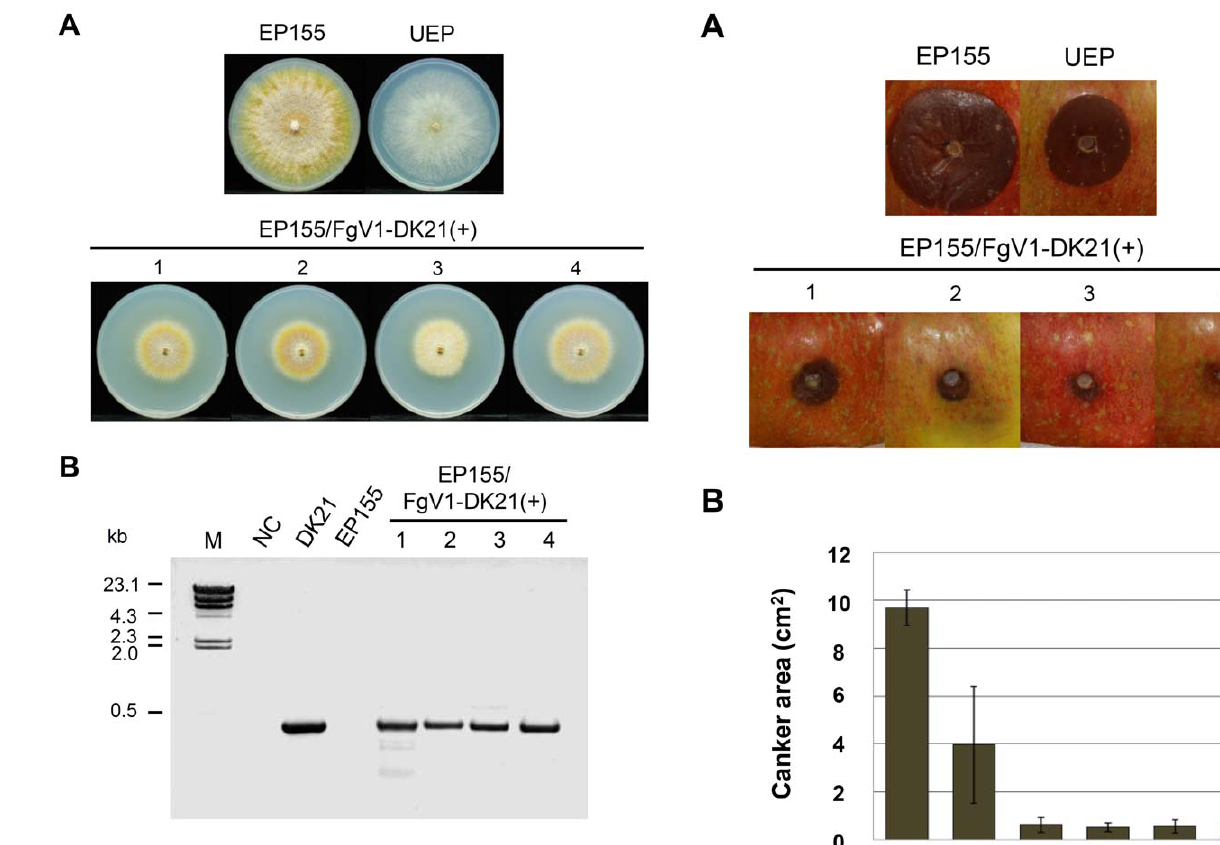
Figure 7. Phenotype and growth rate of C.parasitica as affected by transmission of dsRNA. Colony morphology (A) and RT-PCR analysis (B). EP155 (hygromycin B-resistant mutant), virus-free C. parasitica strain; UEP, EP155 infected with CHV1; 1 to 4, EP155 infected with FgV1-DK21. Lane M, l DNA- Hind III digested DNA marker; NC, no DNA template.